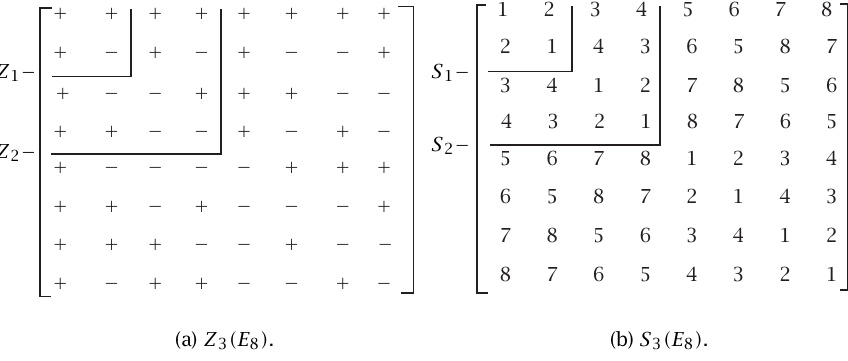
Figure 2.2 . Decomposition of the ⊗ -matrix M 3 (E 8 ) into two special matri- ces. (a) Z 3 (E 8 ) = (z ij ) , i,j = 1 ,..., 8, where (z ij ) = ± 1 ∈ F is a sign matrix . (b) S 3 (E 8 ) = (e ij ) , where e ij = e i ◦ e j = e v , is the structure matrix of the Klein group (E 8 ; ◦ ) (cid:6) C 3 2 of order 8. For notational simplicity, we have used ± to represent ± 1 and the subscript v to represent the element e v ∈ E 8